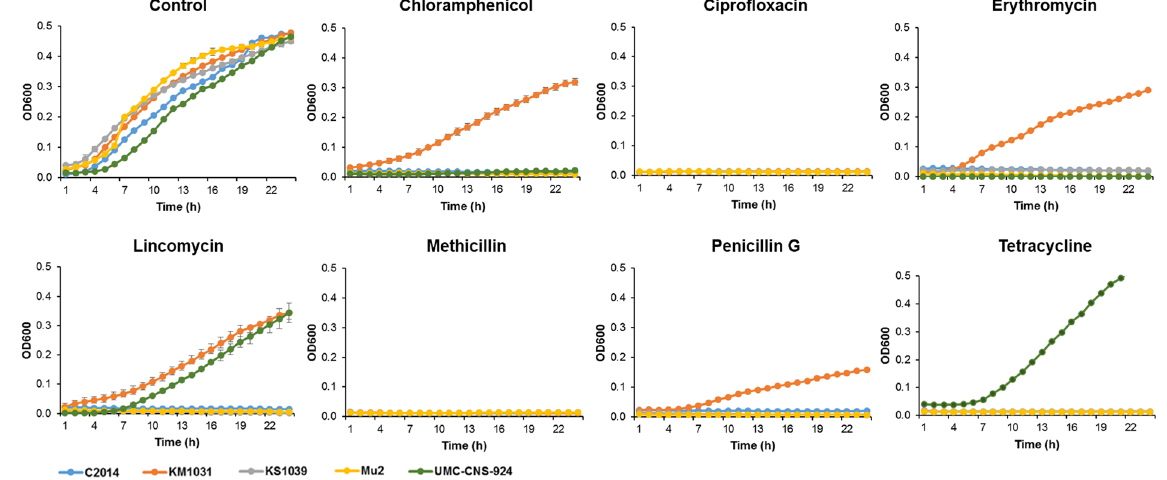
Figure 3. Growth of five S . equorum strains in the presence of